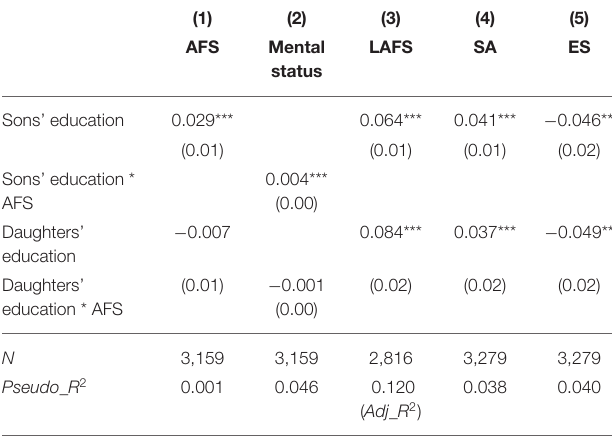
TABLE 6 | Mechanism analysis by